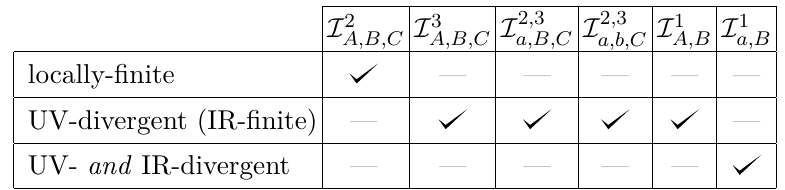
— . All these integrals are weight-1 ⊂ B (4) 2 2